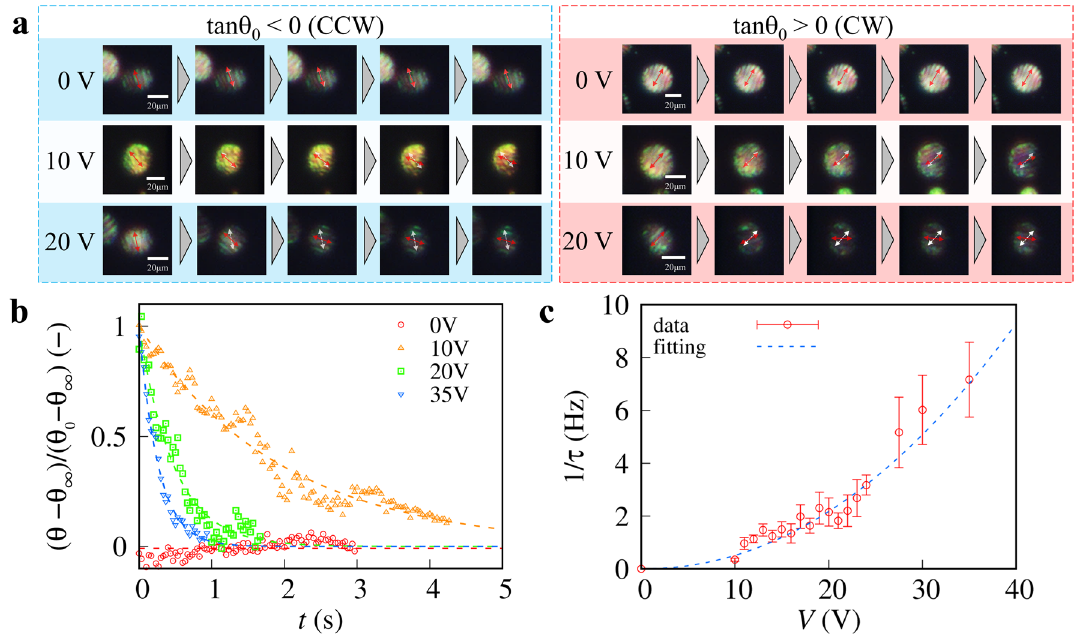
Figure 2. Applied voltage dependence of rotational behavior of LCDs. (a) POM images of LCDs under voltages of 0, 10, and 20 V. The sign of tan θ 0 determines the rotational direction. Images were captured every 0.5 s. We show the direction of n and the initial direction as red and white dashed arrows, respectively. (b) The time evolution of the normalized direction θ = (θ − θ ∞ )/(θ 0 − θ ∞ ). The dashed lines represent the best fits for single exponential functions. In the case of 0 V, the direction was normalized as θ (0 V) as (θ − θ ∞ )/θ 0 , and the mean is displayed as a dashed line. (c) V dependence of 1/τ. The dashed line represents the best fit determined by a power function (∞ α V β ). The fitting parameters α and β are 4.1 (± 2.0) mV −2 ms −1 and 2.1 ± 0.2,